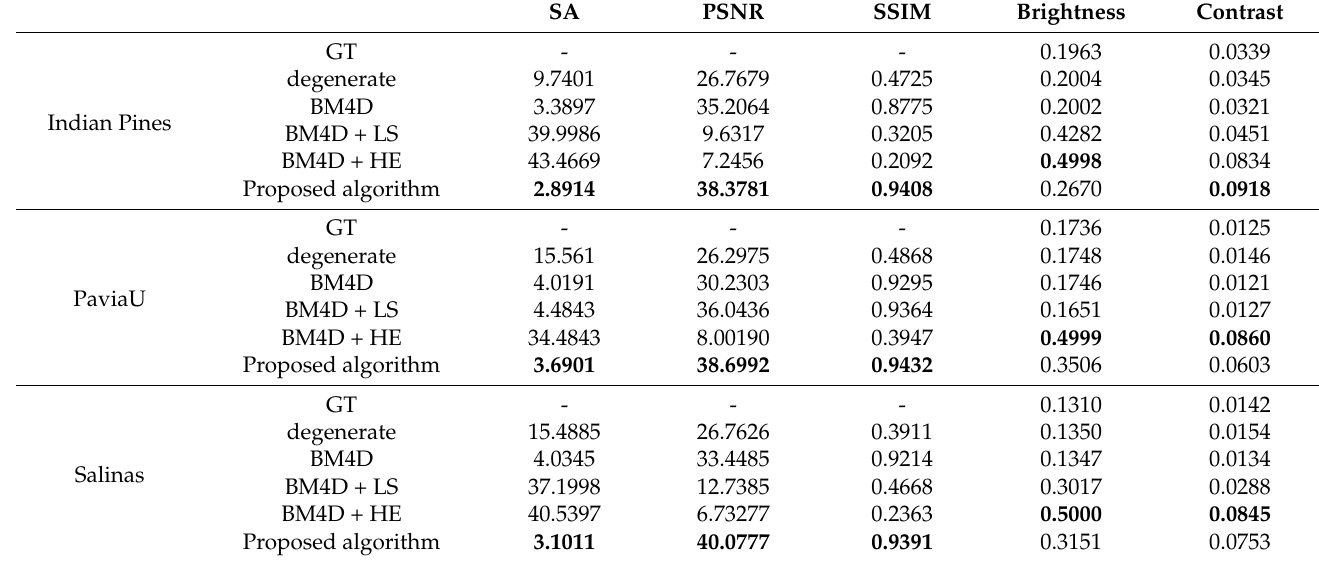
Table 2. The quantitative results of three pubic datasets. (Bold texts indicate the best